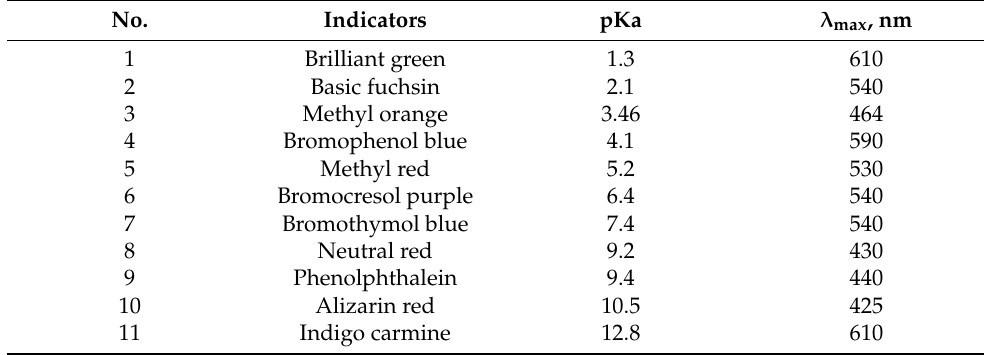
Table 1. The main characteristics of the